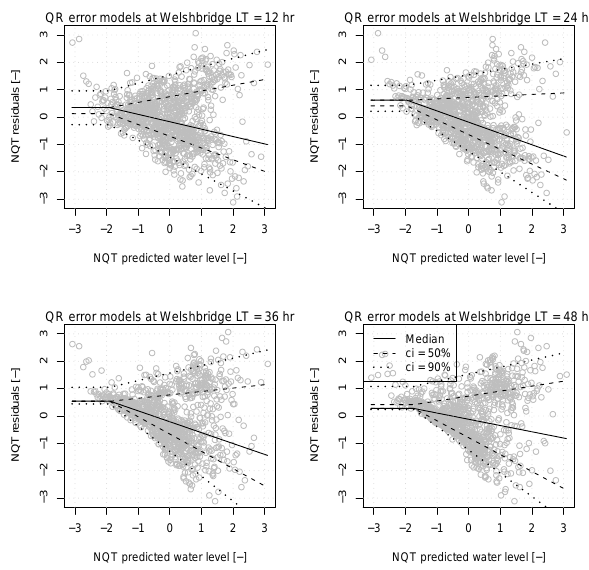
Fig. 2. Transformed forecast errors versus transformed forecasted water levels (both in Gaussian domain) together with the derived Quantile Regressions for the different confidence